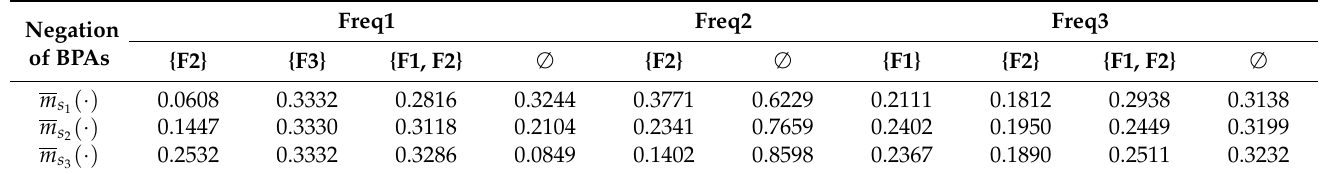
Table 5. Negation of BPAs.